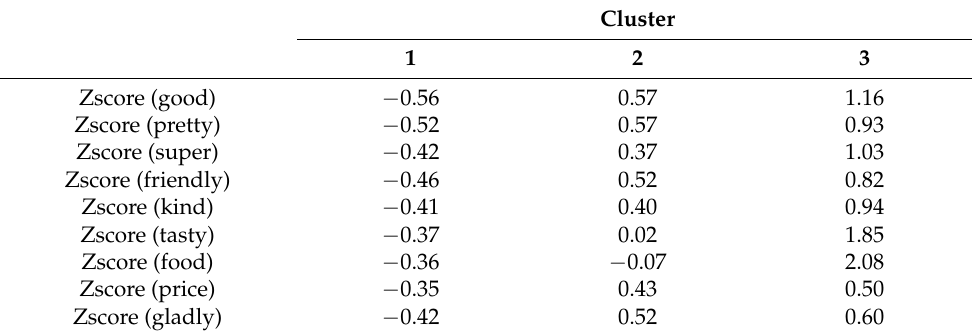
Table 6. Final cluster centers for winery brand image types.